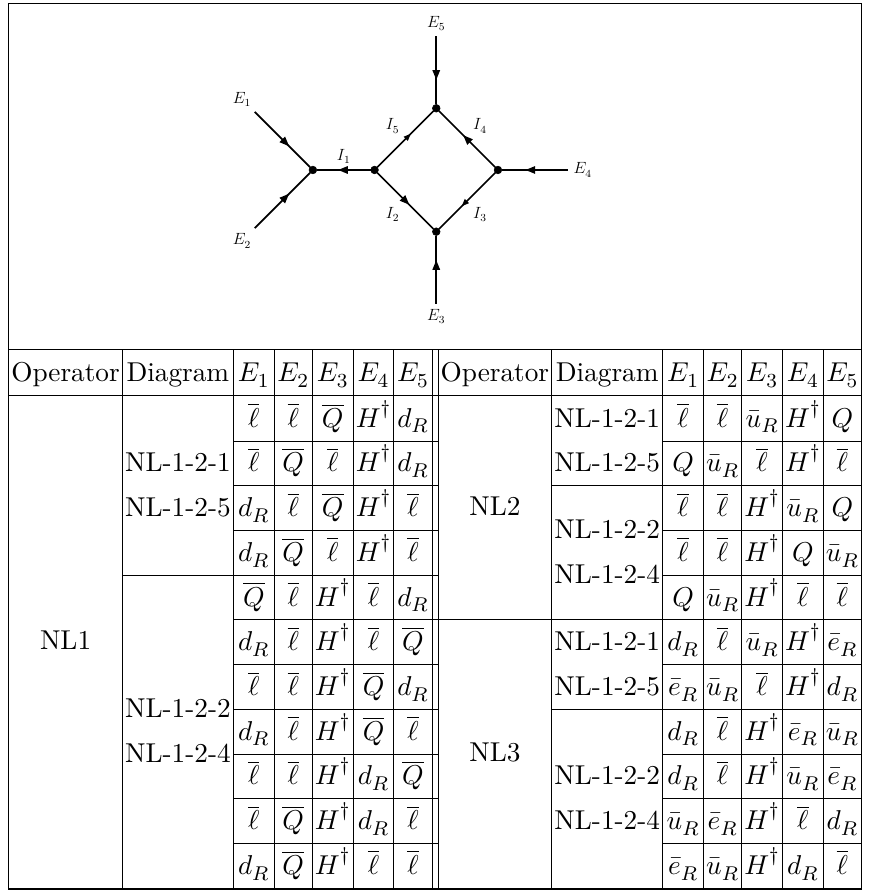
Table 3. The possible external field attachments for the topology NL-1-2, where the external and internal fields are labelled as E